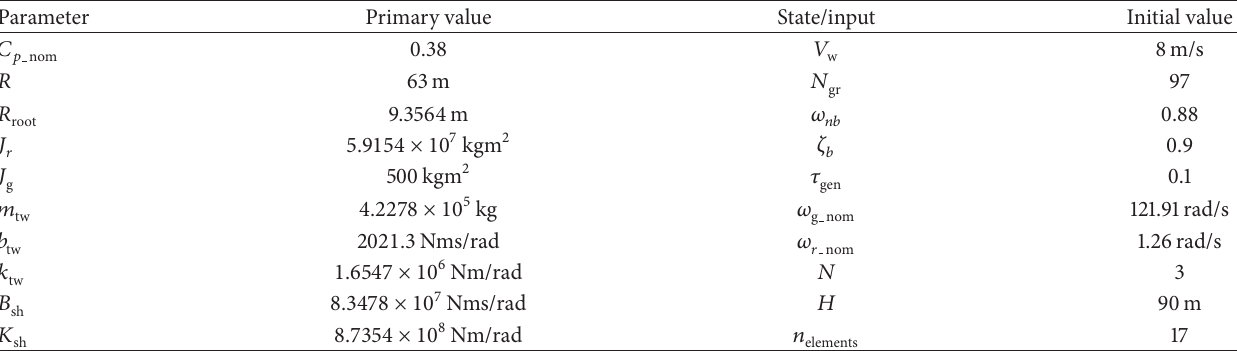
Table 2: Typical parameter and initial state values for simulation.